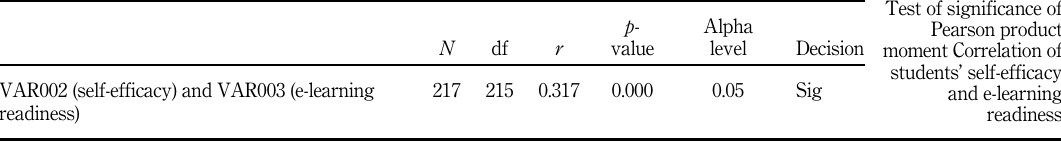
Table 5. F -statistics of